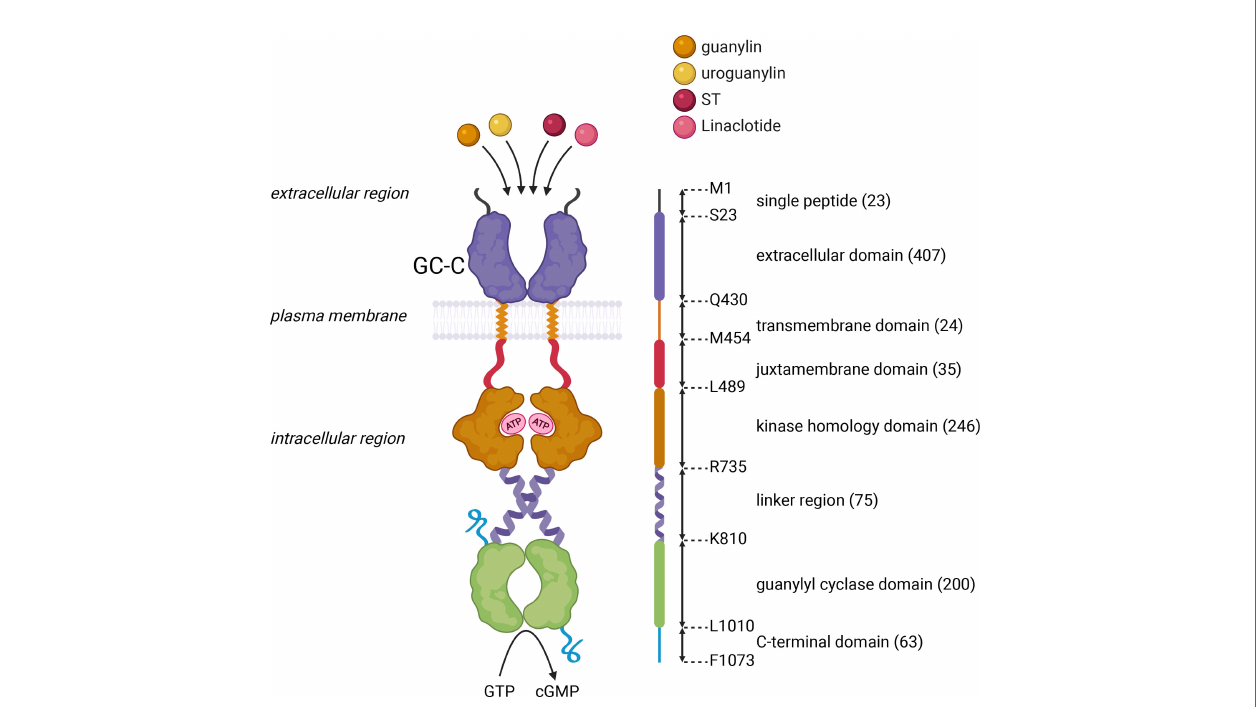
FIGURE 2 | Schematic representation of the domain architecture of GC-C. GC-C is predicted to be a homodimeric multidomain protein that includes an extracellular domain that binds peptide ligands, a transmembrane domain, a juxta-membrane domain, a kinase homology domain that binds ATP, a linker region, a guanylyl cyclase domain that forms a head-to-tail dimer, that converts GTP to cGMP, and a C-terminal domain. The domain boundaries of human GC-C are shown in the linear schematic on the right of the domain architecture, with a single letter amino acid code at each position. Numbers in brackets represent the number of amino acids within the predicted domain boundaries. The fi gure was prepared using